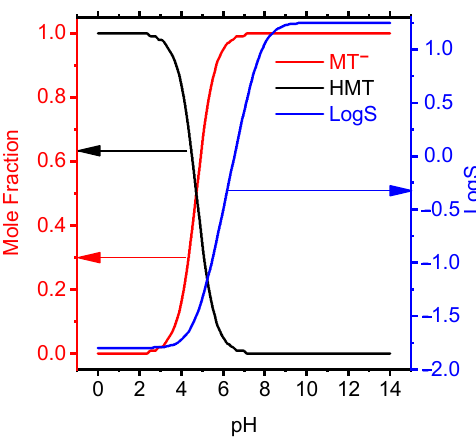
Figure 4. Mole fraction and LogS data of MT depending on pH by the calculated semiempirical method using the ACDChem software